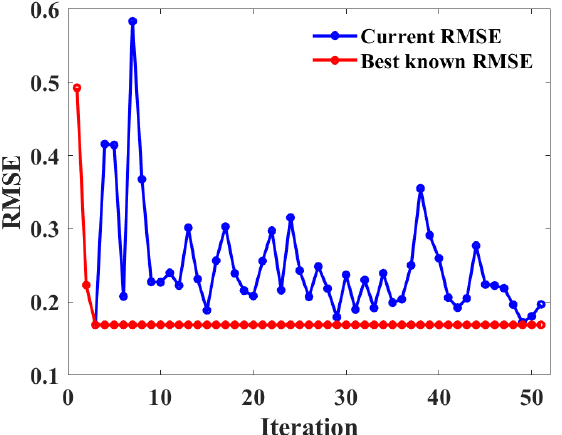
Materials 2021 , 14 , x FOR PEER REVIEW Figure 9. Relationship between RMSE value and iteration number. Figure 9. Relationship between RMSE value and iteration number.